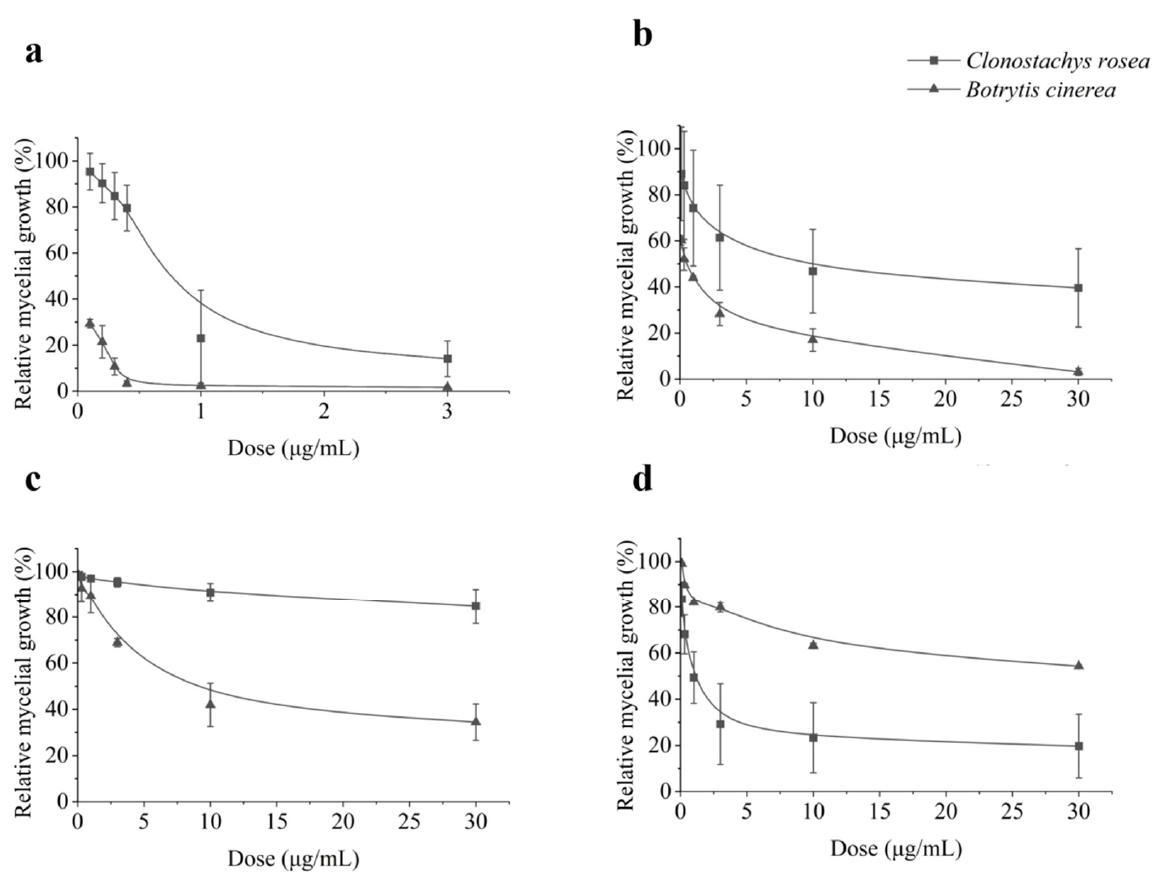
Figure 1. Contrasting in vitro relative growth of Clonostachys rosea and Botrytis cinerea on different concentrations of ( a ) carbendazim, ( b ) tebuconazole, ( c ) boscalid, and ( d ) pyraclostrobin in PDA medium. Mean and standard deviation from the average of eight C. rosea isolates (isolates JLB-7-1, 67-1, SYP-4-2, SHW-1-1, YJS-3-2, GS6-1, NHH-48-2, and BD-2-1) and two B. cinerea (YN80 and YN81) isolates were